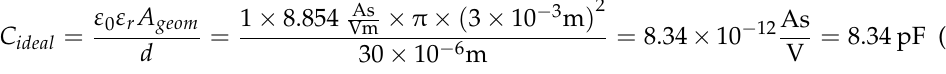
propagates in the air